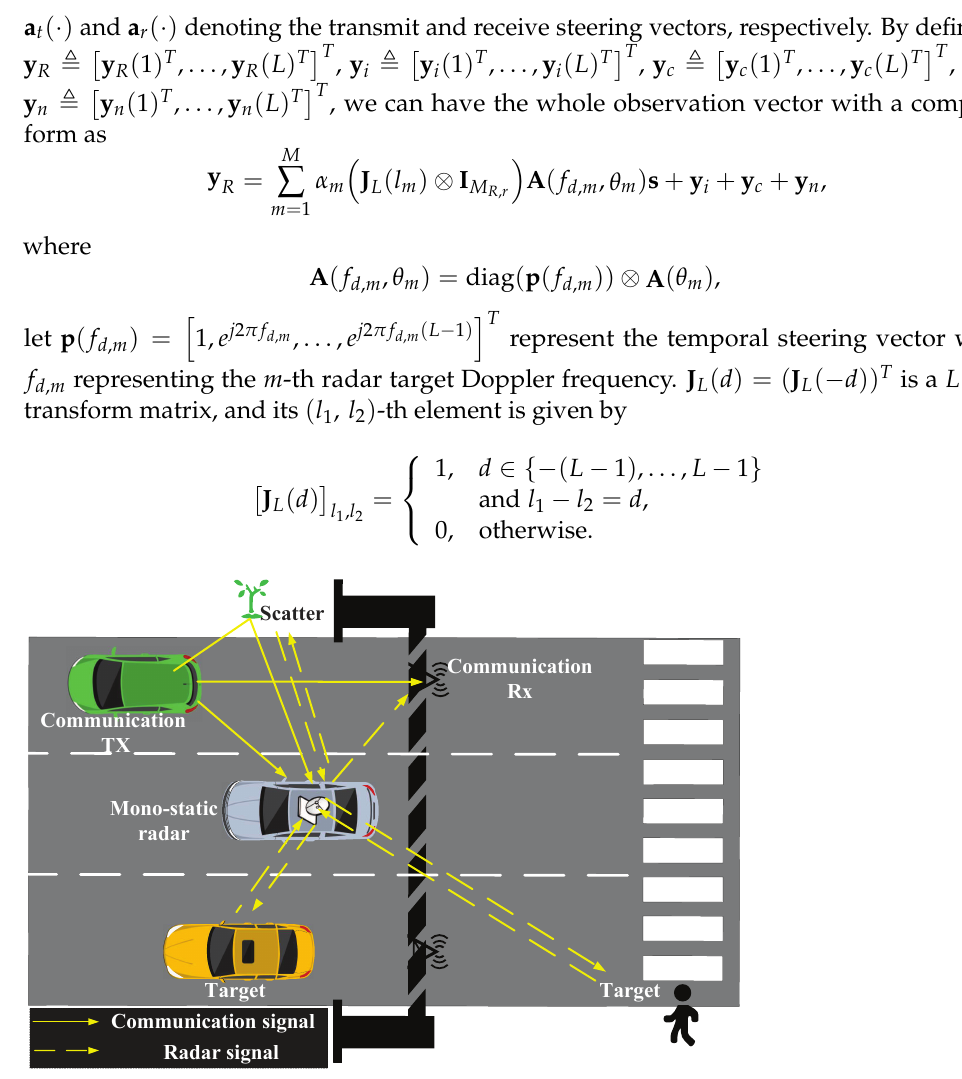
Figure 1. A Photo illustration of Radar and Communication Spectral Coexistence on Vehicle